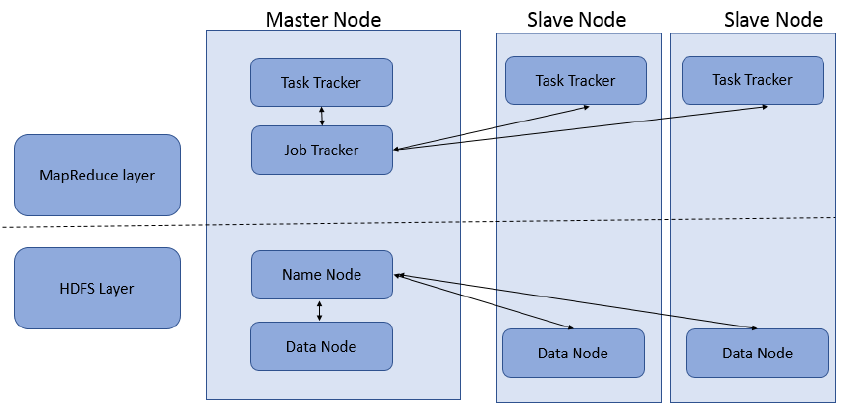
Figure 3. The master-slave